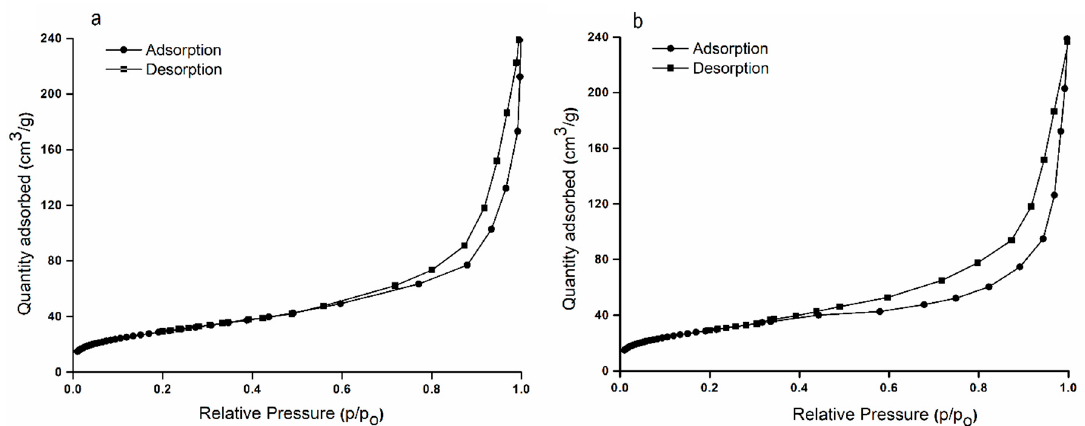
Figure 4. The nitrogen adsorption / desorption isotherms of HAp ( a ) and HApWW ( b ) samples. Table 2. Parameters of nitrogen adsorption/desorption isotherms of HAp and HApWW samples.